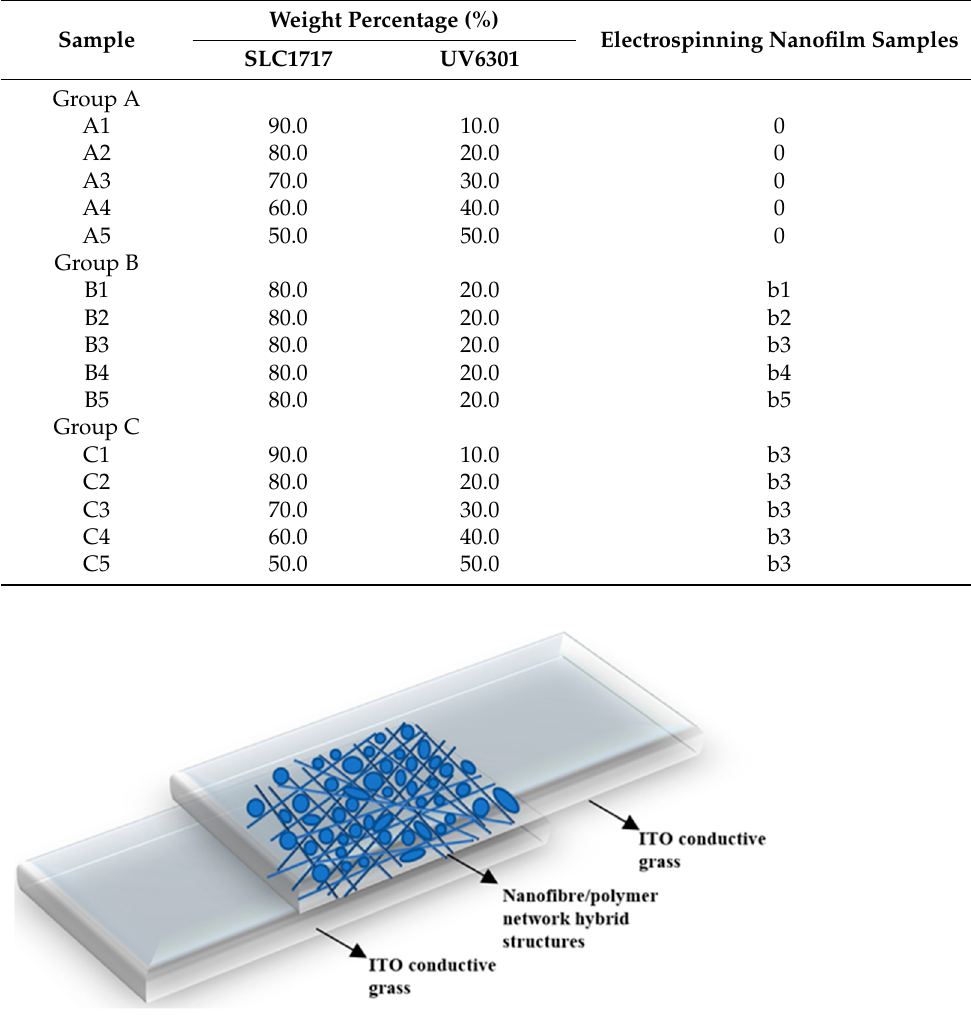
Figure 11. The structure of liquid crystal cell after polymerization.